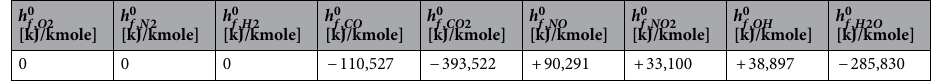
Table 7. The enthalpy of formation of chemical species in the flow sections “2”. p 0 = p 1 = p 2 = 0.8 MPa, T 0 = T 1 = 298 K, T 2 = T fg , 37–43 .